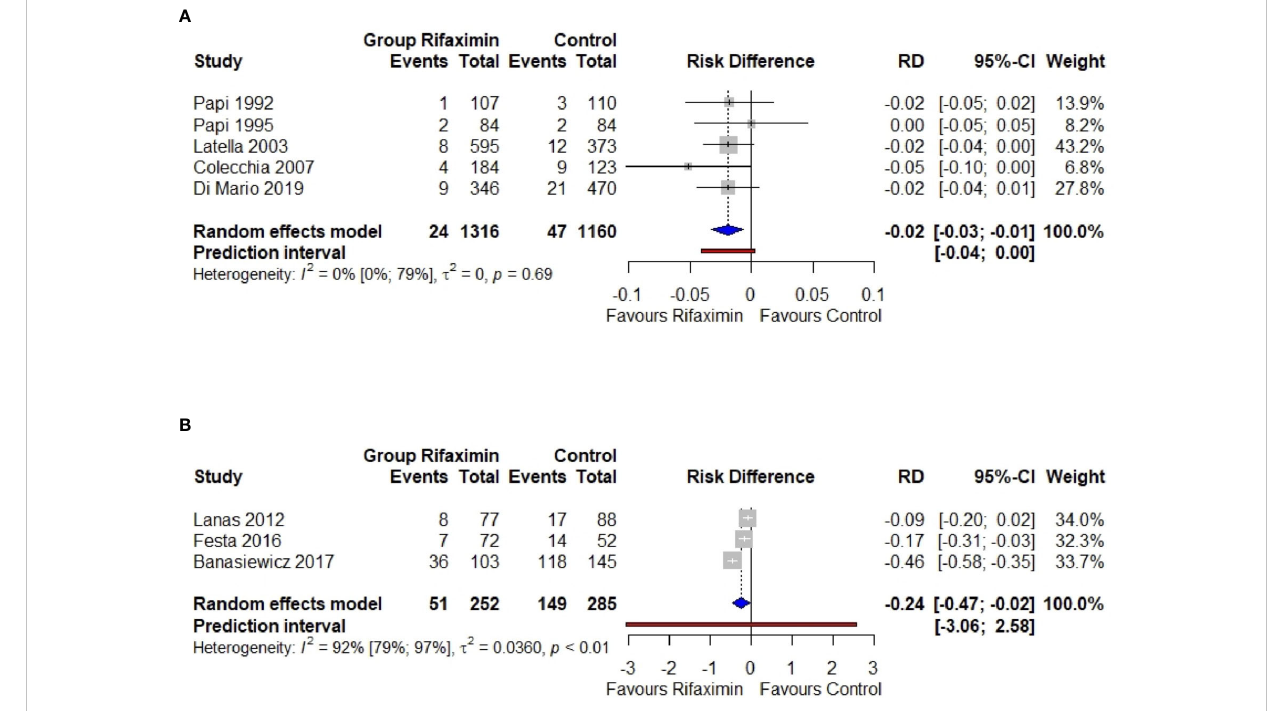
FIGURE 2 Meta-analysis regarding the risk difference between the rifaximin group and controls as the primary (A) or secondary (B) prevention of diverticulitis. RD, risk difference; 95%-CI, con fi dence intervals at 95%. The vertical line indicates the ‘ no difference ’ point between the two options. Squares represent the adjusted risk difference. Diamonds represent the pooled risk difference for all studies. Horizontal lines represent 95% CI.